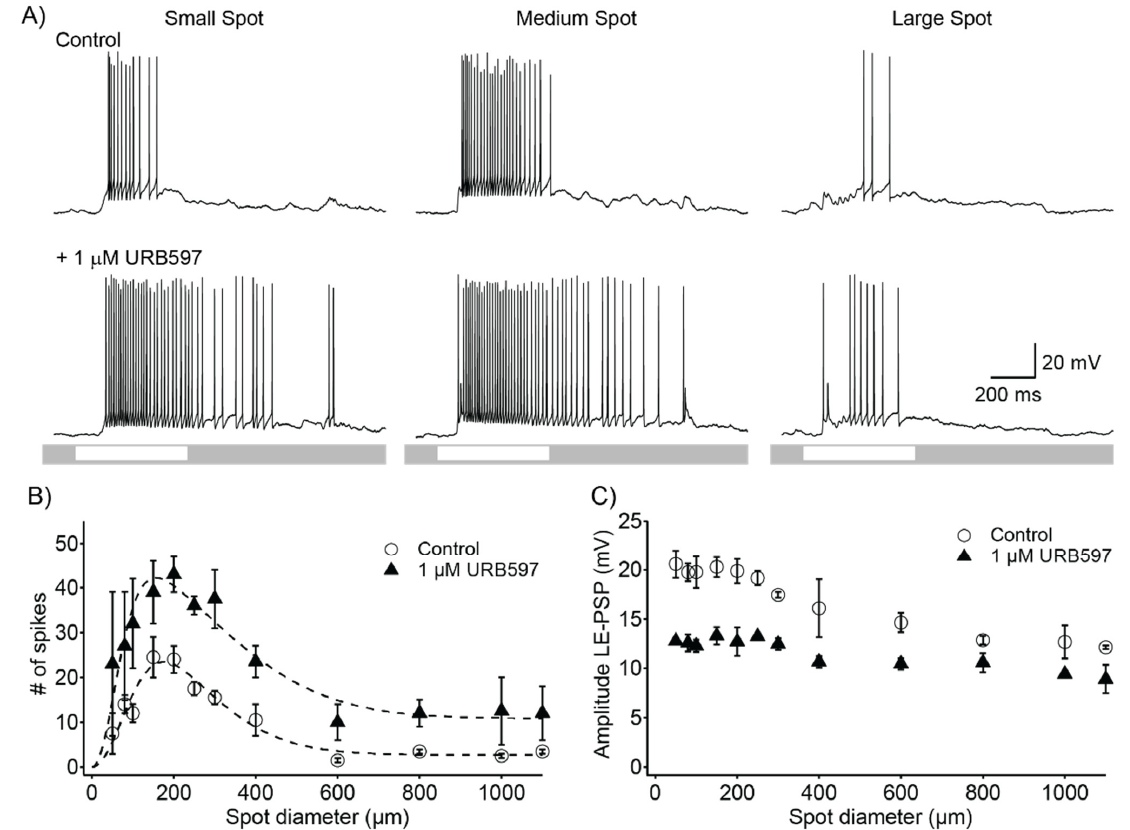
Figure 1. Effects of 1 µM URB597, a fatty acid amide hydrolase (FAAH) inhibitor, on light evoked responses of an ON retinal ganglion cell. ( A ) Responses from a representative cell to different sized spot stimuli. After addition of 1 µM URB597, response strength to all spot sizes is greatly increased. Small, medium, and large spot sizes were 50, 200, and 1100 µm, respectively. Lighter bars on grey background at the bottom of the traces indicate the timing of stimulus delivery and stimulus contrast. ( B ) Area–response function for spike count for the cell shown in ( A ) in control conditions (open circles) and in the presence of 1 µM URB597 (filled triangles). This cell showed the classical receptive field organization characteristic of many retinal ganglion cells, with an excitatory center and an inhibitory surround. Dashed lines show the best predictions of a difference-of-Gaussians of the receptive field. (# symbolizes number) ( C ) Area–response function for amplitude of light-evoked post-synaptic potential (LE-PSP) in control conditions (open circles) and in the presence of 1 µM URB597 (filled triangles). Symbols represent the mean and error bars are the standard error of the mean.